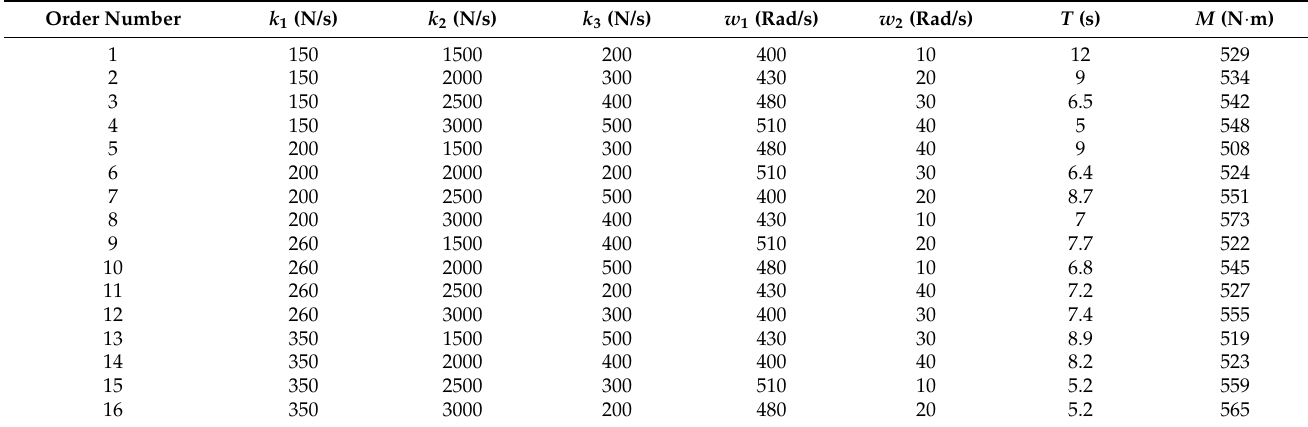
Table 5. The simulation results of the orthogonal experimental design.